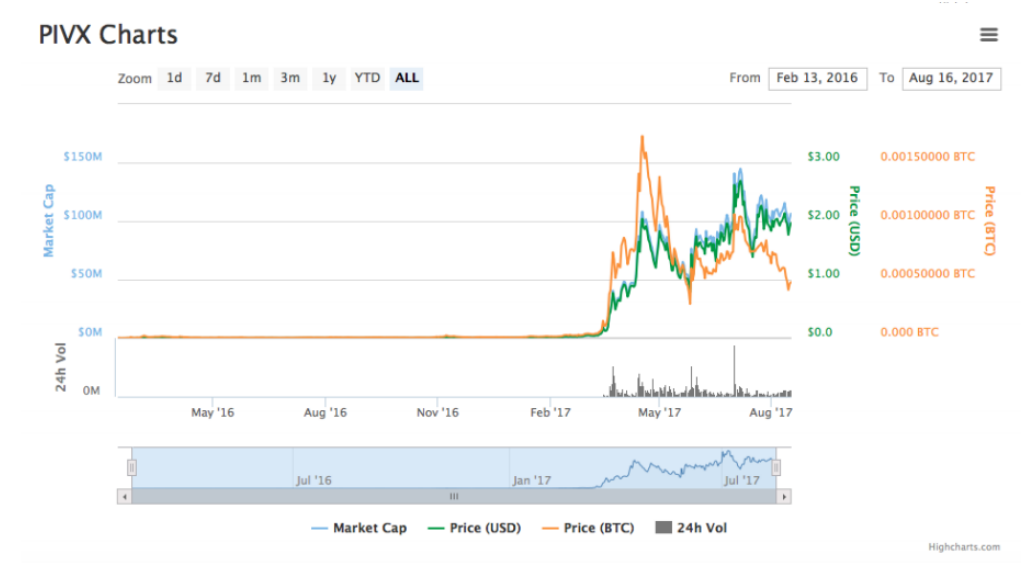
Fig 2. Year-to-date increases for Dash (previous page) and PIVX (above), retrieved from